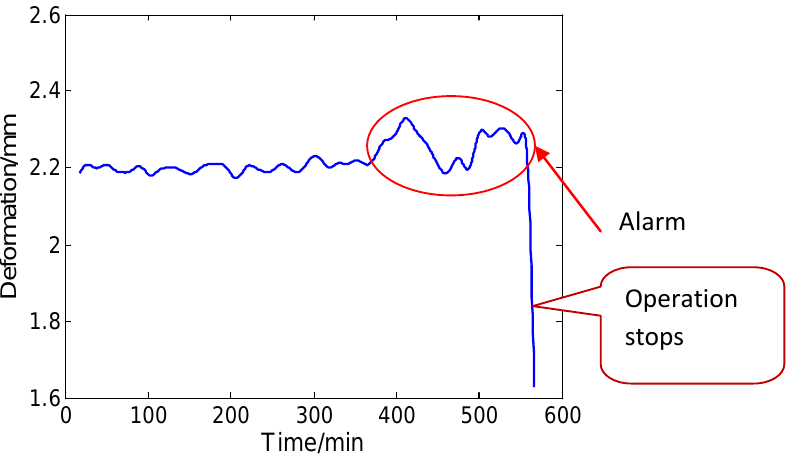
Figure 9. Deformation monitoring curve with